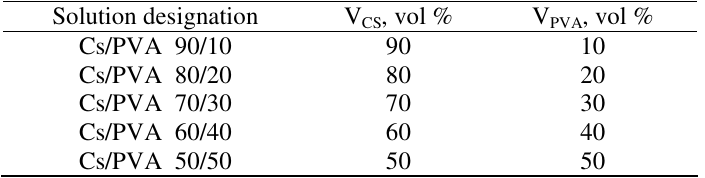
Table 1. Composition of the chitosan and PVA